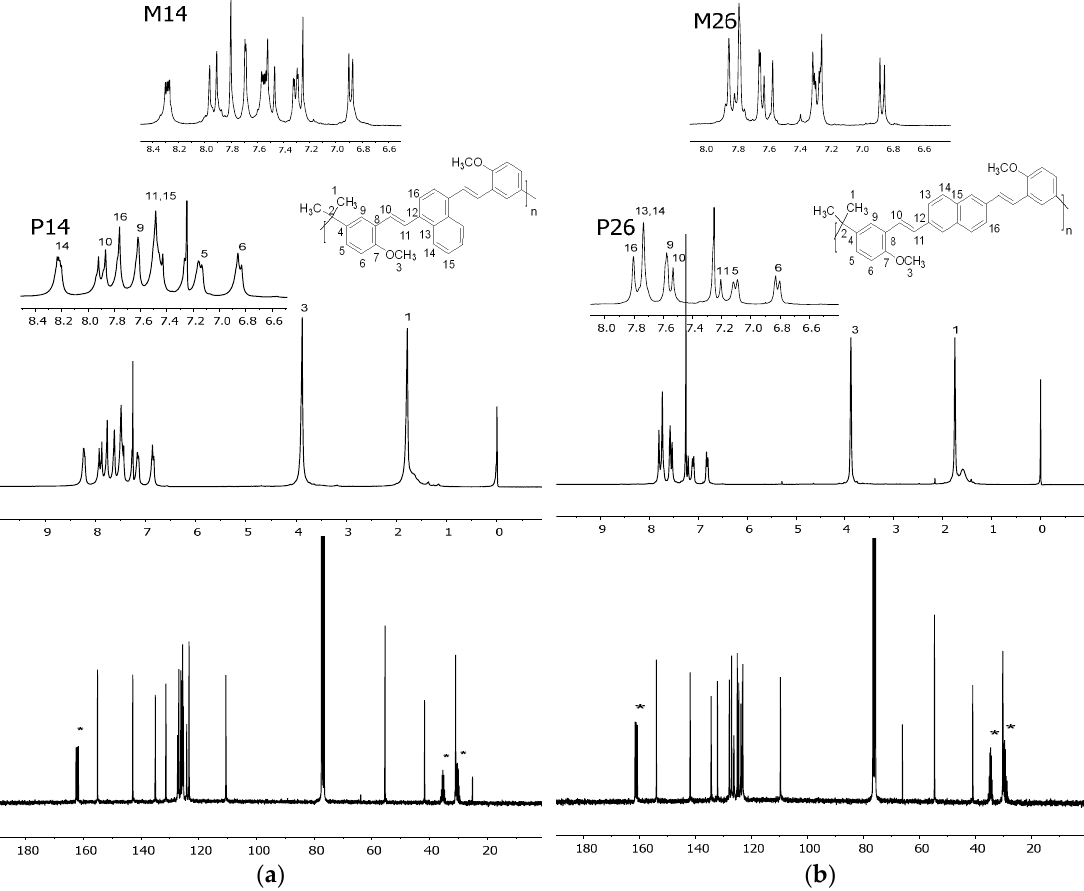
Figure 1. 1 H NMR (CDCl 3 ) (top) and 13 C NMR (CDCl 3 with 5% DMF) (bottom) spectra of polymers ( a ) P14 and ( b ) P26 . The 1 H NMR spectra of the expanded aromatic region of both model compounds and polymers are also shown. * 13 C signal from DMF- d 7 .